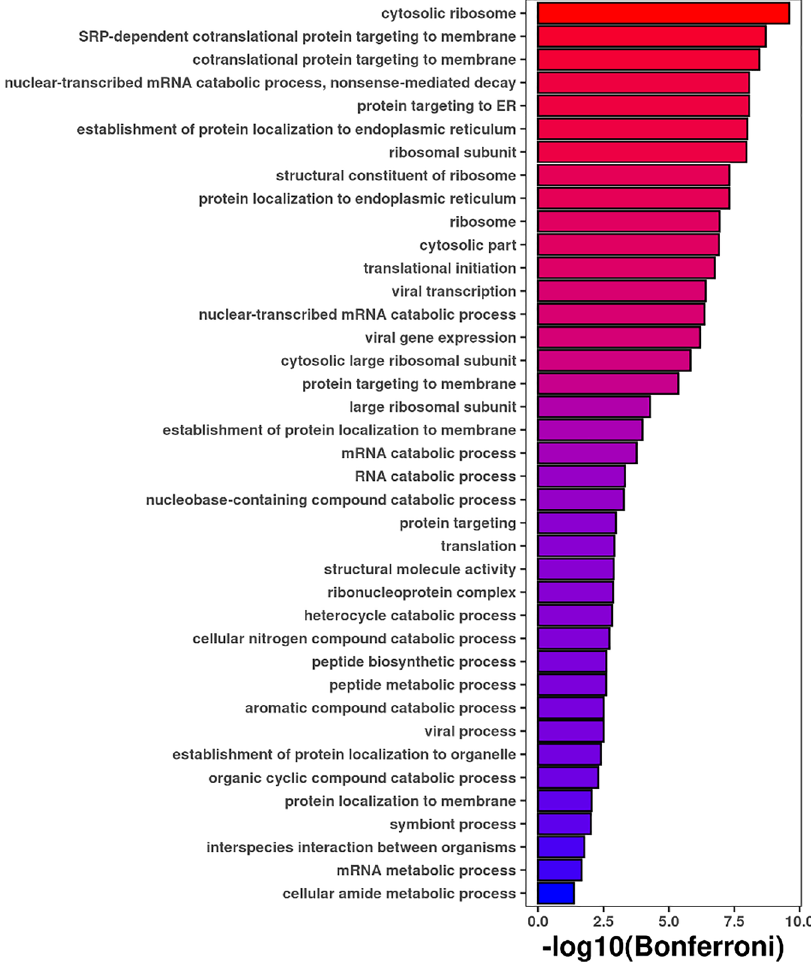
Figure 6. Gene ontology analysis of the “Midnight blue” module (n = 82 genes). Only processes significant after Bonferroni correction are listed, with increasing significance going from blue to